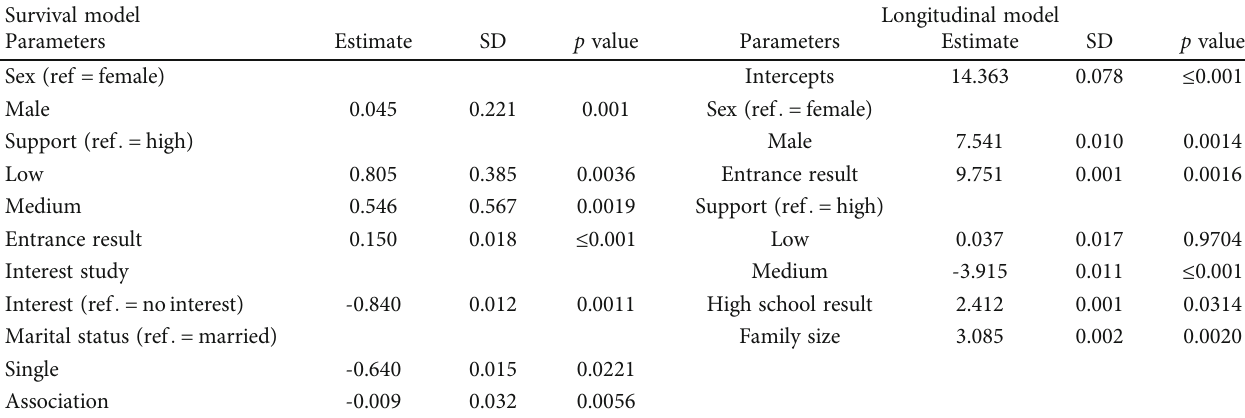
Table 4: Parameter estimates for the joint modeling analysis.